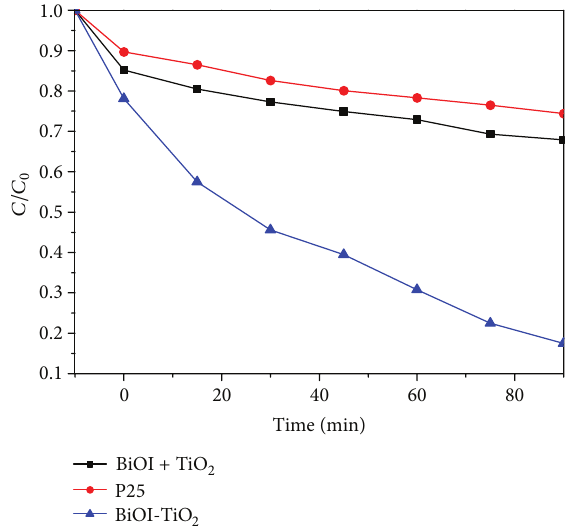
Figure 8: Effect of initial pH on BPA removal rate. Catalyst dosage = 0.5 g/L, BPA concentration = 20 mg/L.